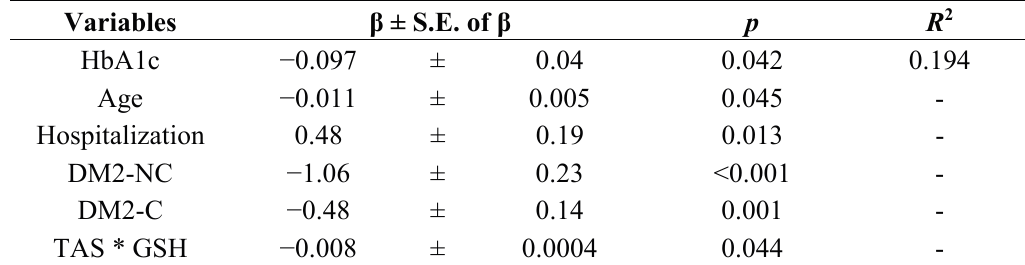
Table 3. Associations of Nrf2 levels with HbA1c, age, hospitalization, diabetic groups and oxidative stress. Multiple linear regression including diabetic and control group. Results are shown as β ± S.E. of β , p of each regressor variable and R 2 of the model including. Nrf2 data were transformed to log scale to avoid heteroscedasticity. HbA1c: glycated hemoglobin, Hospitalization: hospitalization by hypoglycemic events, 0 = no, 1 = yes, DM2-NC and DM2-C dummy variable for groups where DM2-NC include diabetic subjects without glycemic control and DM2-C include diabetic subjects with glycemic control, TAS * GSH: interaction of total antioxidant status (plasma DPPH) and reduced